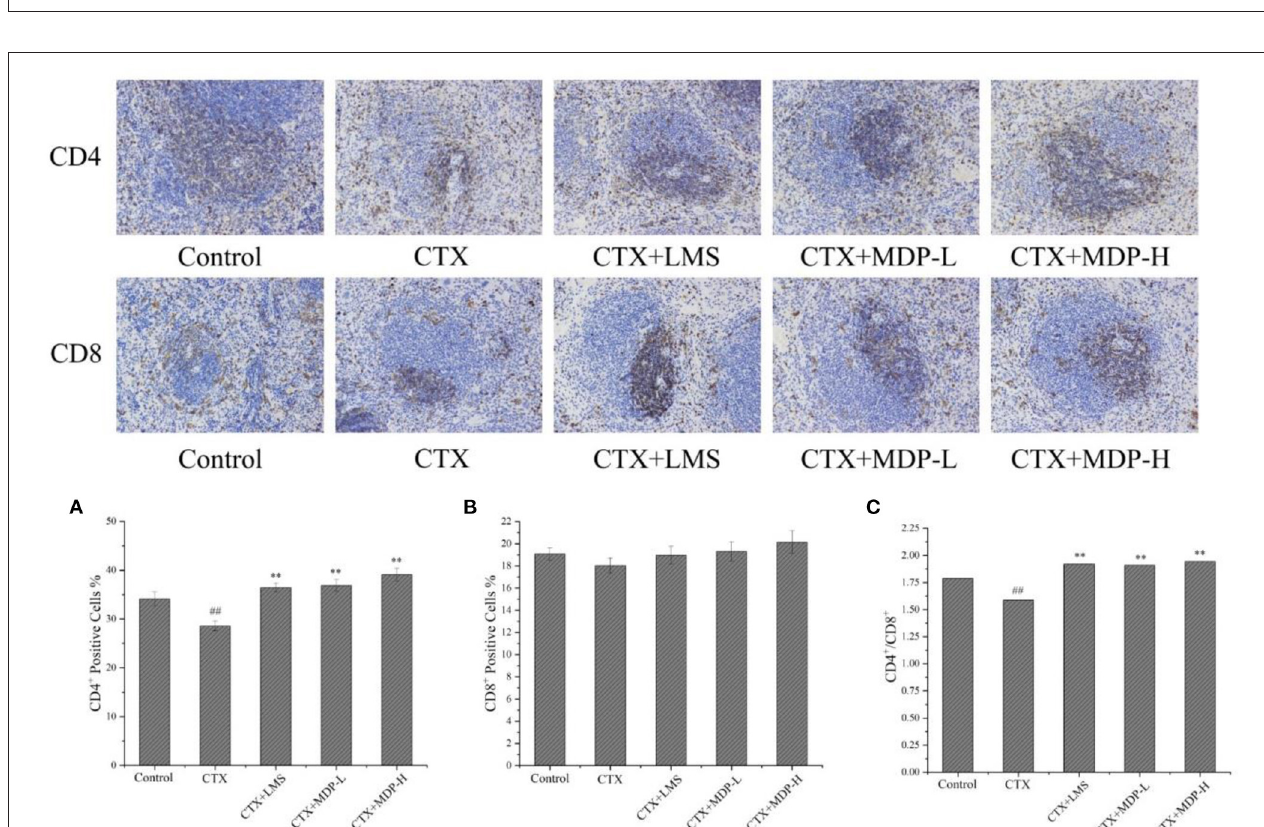
FIGURE 10 | Effect of MDP on the T lymphocyte of spleen. (A) Quantitative analysis of the effect of MDP on the CD4 + T lymphocyte of spleen. (B) Quantitative analysis of the effect of MDP on the CD4 T lymphocyte of the spleen. (C) Effect of MDP on the CD4 + /CD8 + of the spleen. Values are given as means + ## P < 0.01 vs. control group; ** P < 0.01 vs. CTX group.